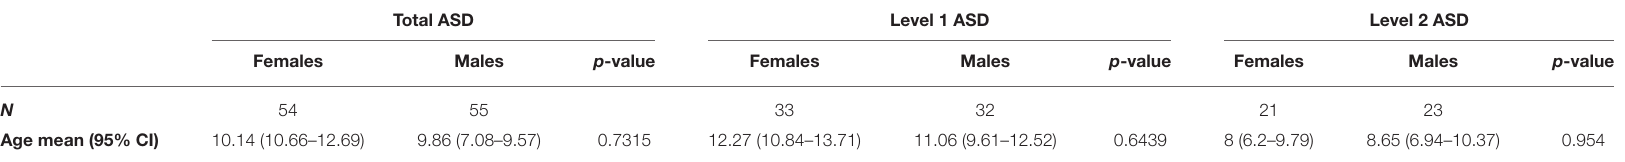
TABLE 1 | Demographic and clinical characteristics of the sample.